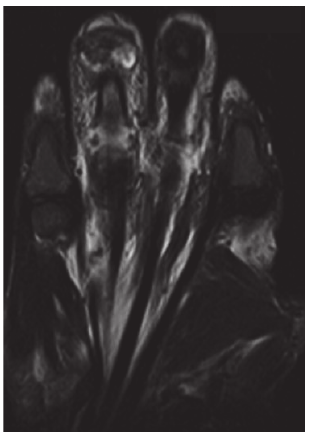
Figure 1: X-ray of right hand, severe degenerative changes at the fourth PIP joint with medial subluxation of the middle phalanx, and periosteal reaction.